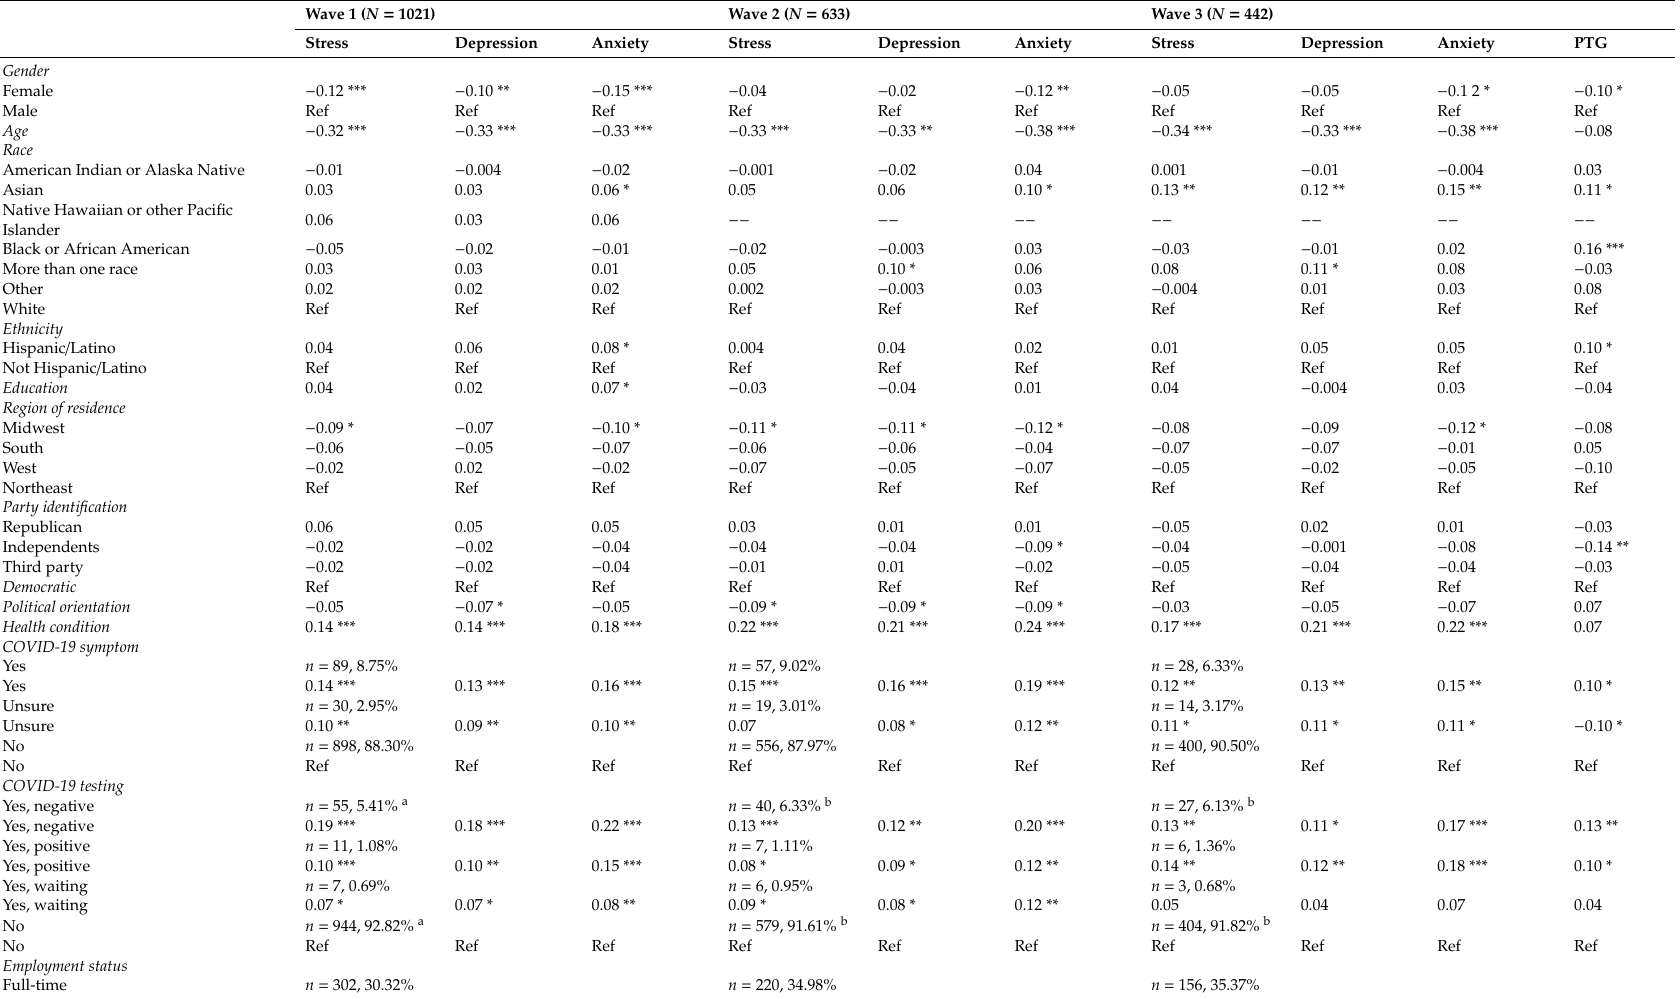
Table 2. Simple Regression of Mental Health Outcomes on Demographic Predictors and Change in Demographic Predictors over